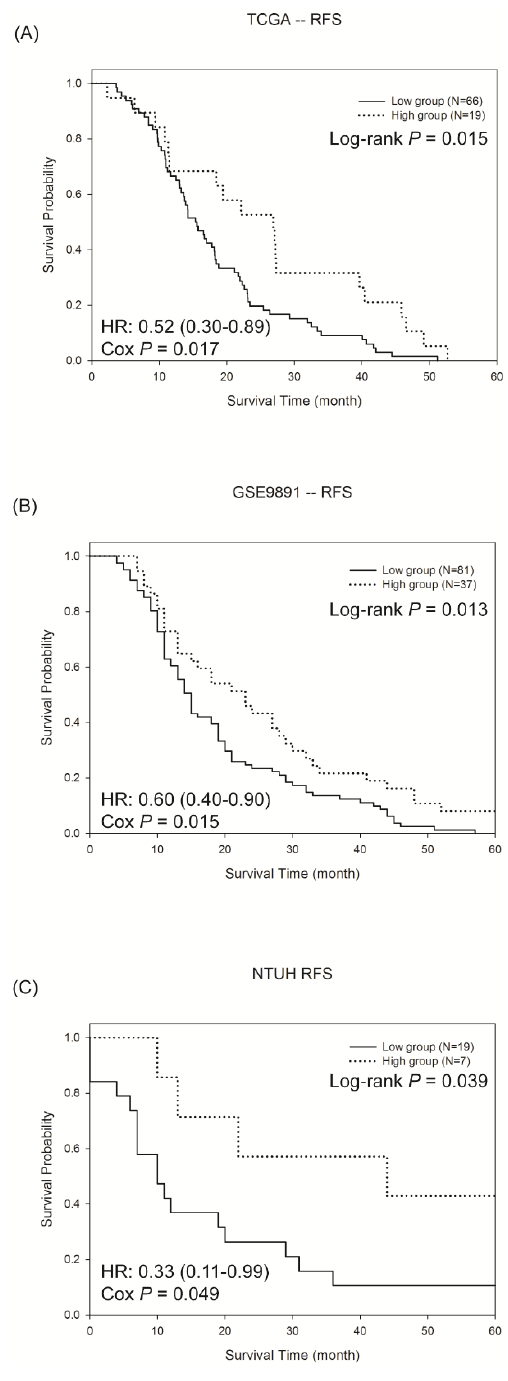
Figure 2. The Kaplan-Meier survival curves of the recurrence free survival (RFS) in the high and low response groups in the ( A ) TCGA dataset, ( B ) GSE9891 dataset and ( C ) NTUH patients. Patients of high response group had longer RFS than low response group in the three cohorts. The hazard ratio (HR) was estimated by the Cox hazard regression model.